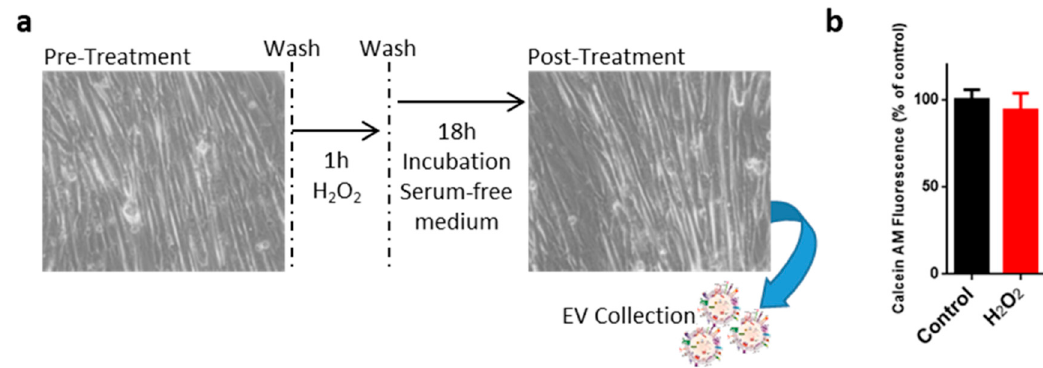
Figure 1. Exposure of myotubes to oxidative stress. C2C12 myotubes were treated with 0.3 mM H 2 O 2 for 1 h and then extracellular vesicles (EVs) were collected after 18 h of recovery (blue arrow) ( a ); cell viability was evaluated after the collection of EVs using calcein AM, the results are represented as mean ± standard deviation (SD); n = 3 ( b ).